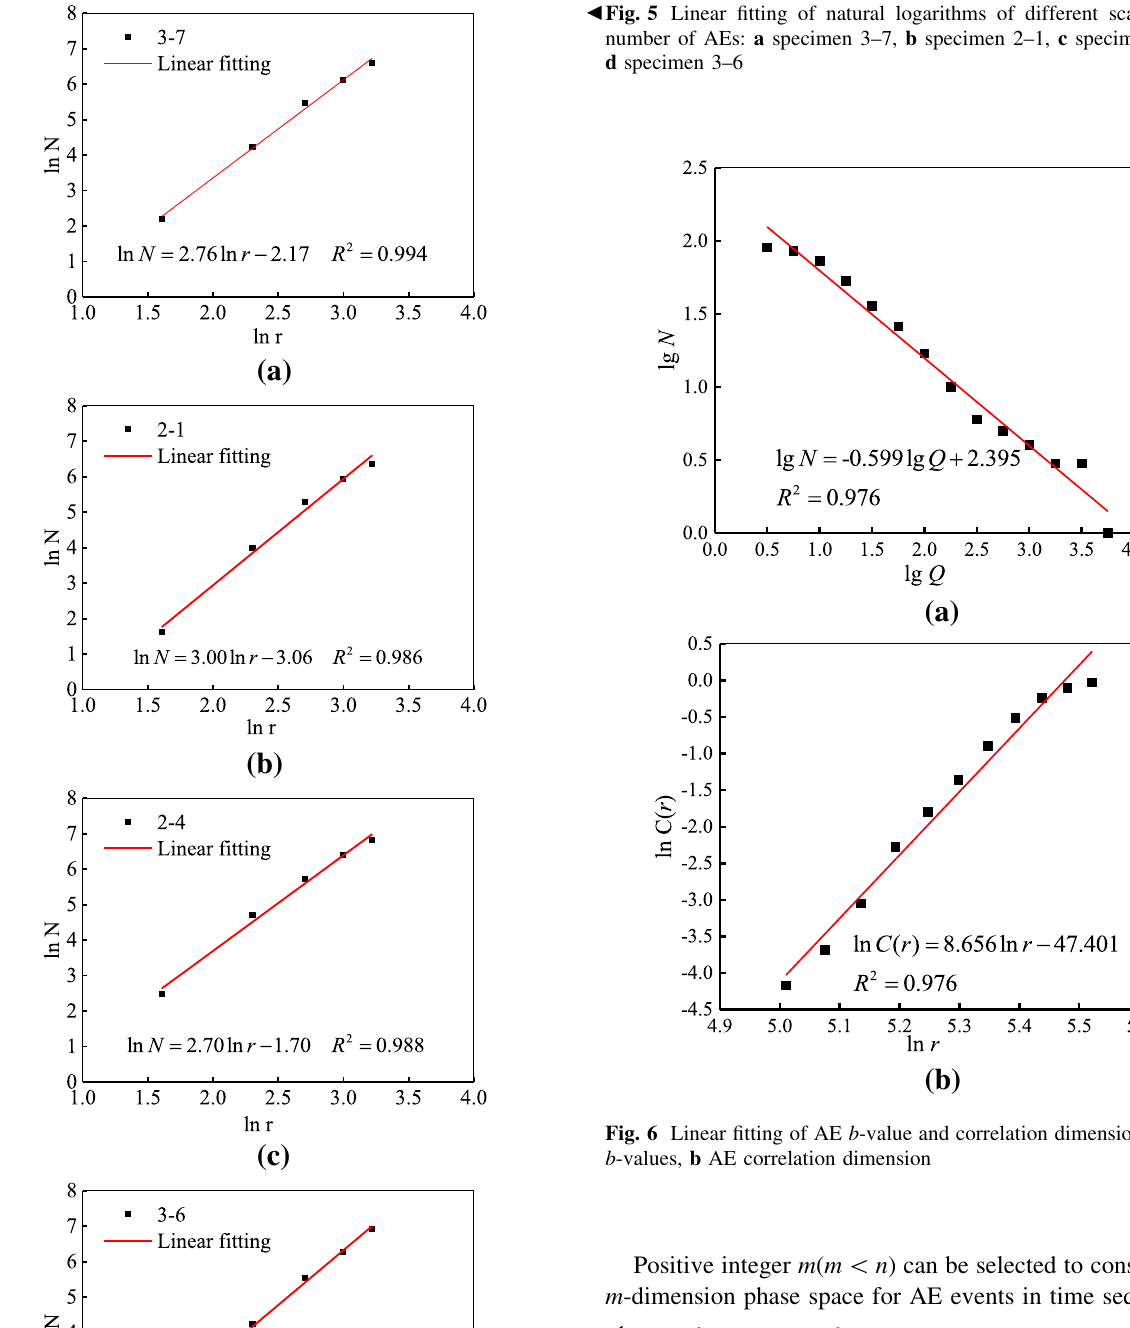
b Fig. 5 Linear fitting of natural logarithms of different scales and